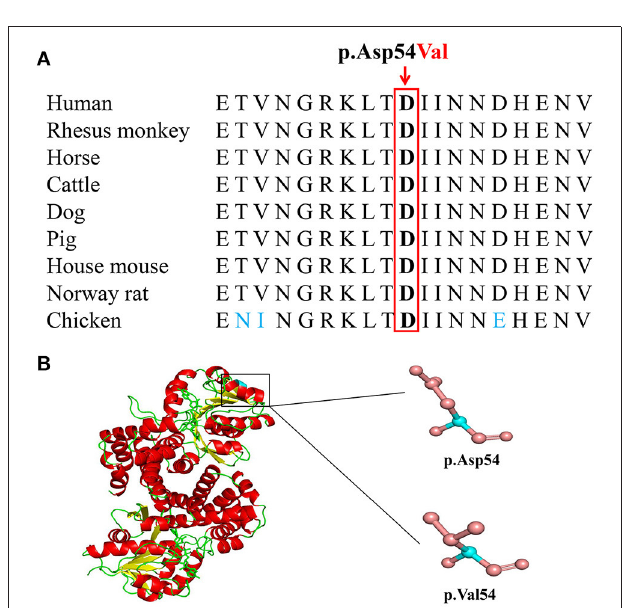
FIGURE 3 | The conserved analysis and structural prediction of wildtype and mutant glycerol-3-phosphate dehydrogenase 1 like (GPD1L) proteins. (A) The GPD1L p.Asp54 amino acid residue is conserved in nine species by a multiple sequence alignment program. (B) Structural prediction of wildtype and variant GPD1L